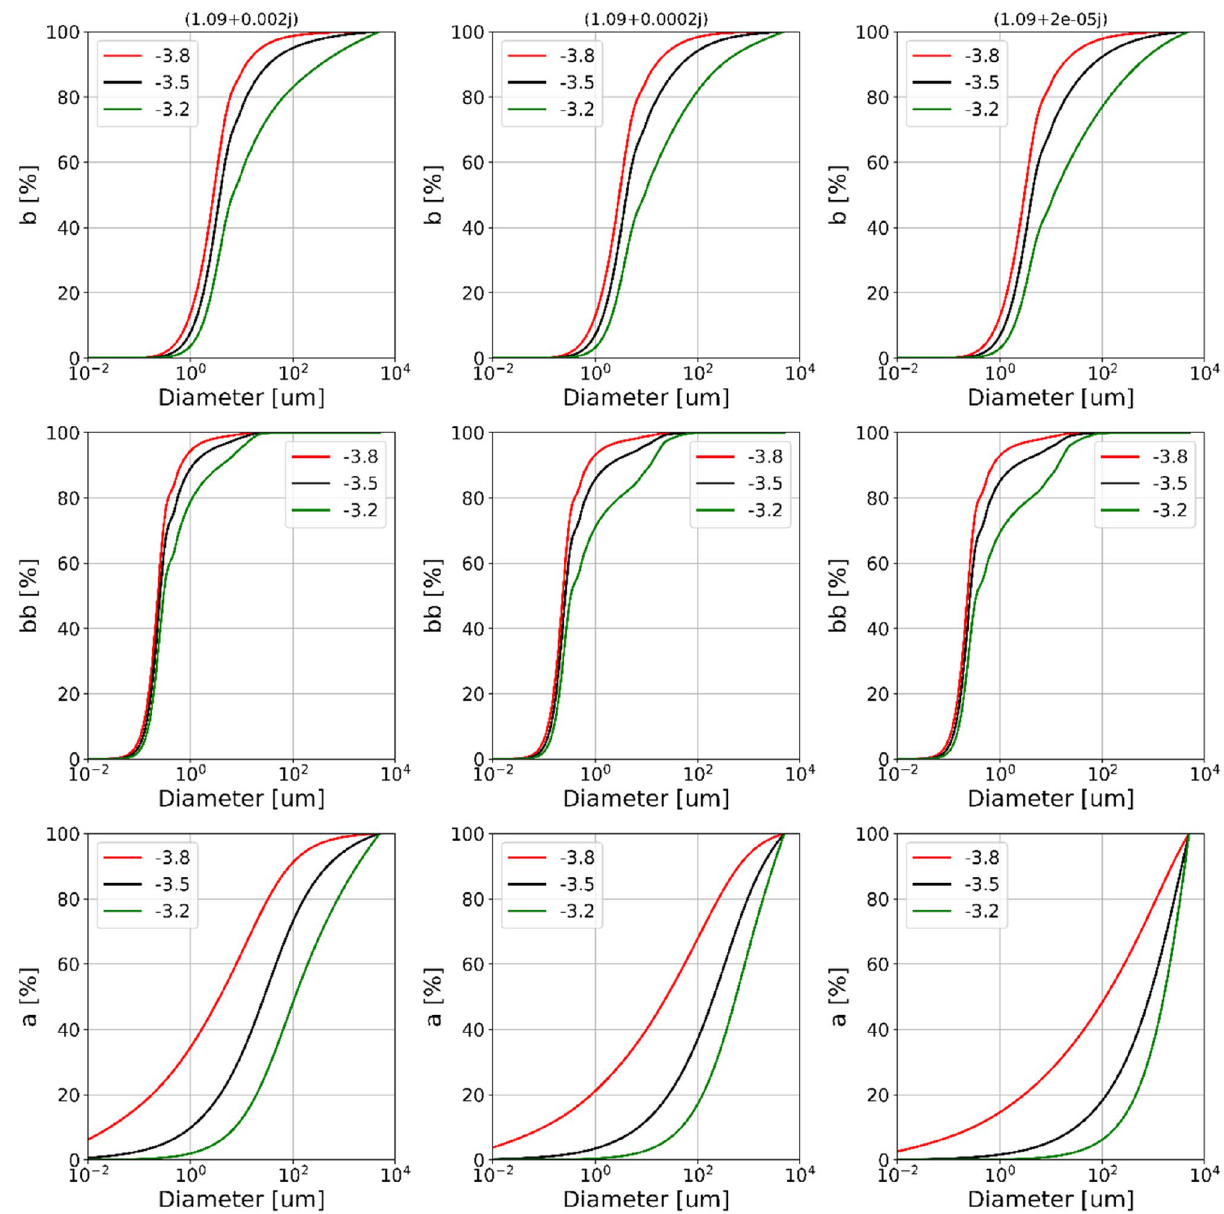
Figure 4. Changing imaginary refractive index (columns) on cumulative contributions to (top row) scattering, (middle row) backscattering, and (bottom row) absorption. Red, black and green lines represent PSD slopes of 3.8, 3.5 and 3.2 respectively. Failure to reach a horizontal asymptote implies that the range of significant particle sizes extends beyond the range of sizes simulated here (0.001–5000